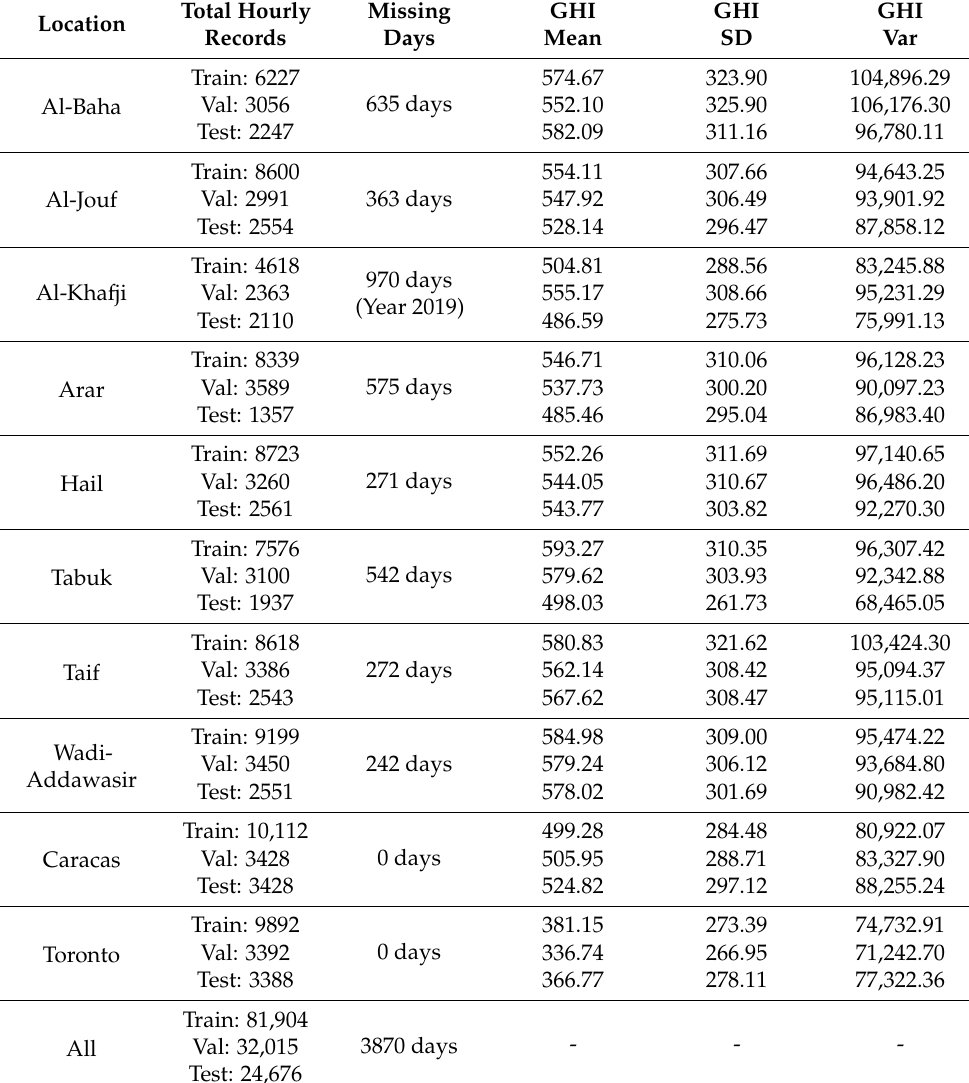
Table 6. Forecasting datasets